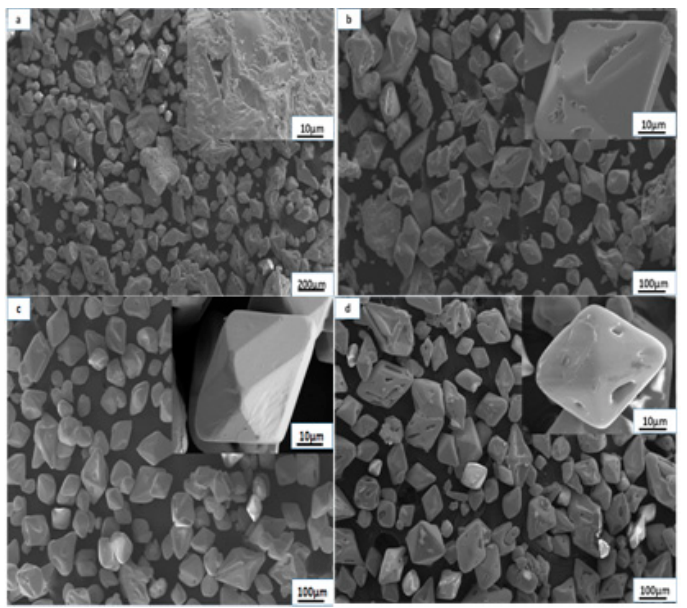
Figure 4. SEM images of the NH 4 ReO 4 recrystallization particles at different agitation intensities ( a —100 rpm; b —150 rpm; c —200 rpm; and d —250 rpm) . Table 1. Specific surfaces and D50s (median diameter) of the samples at different stirring speeds. Agitation Intensity (rpm) Specific Surface (m 2 /kg)